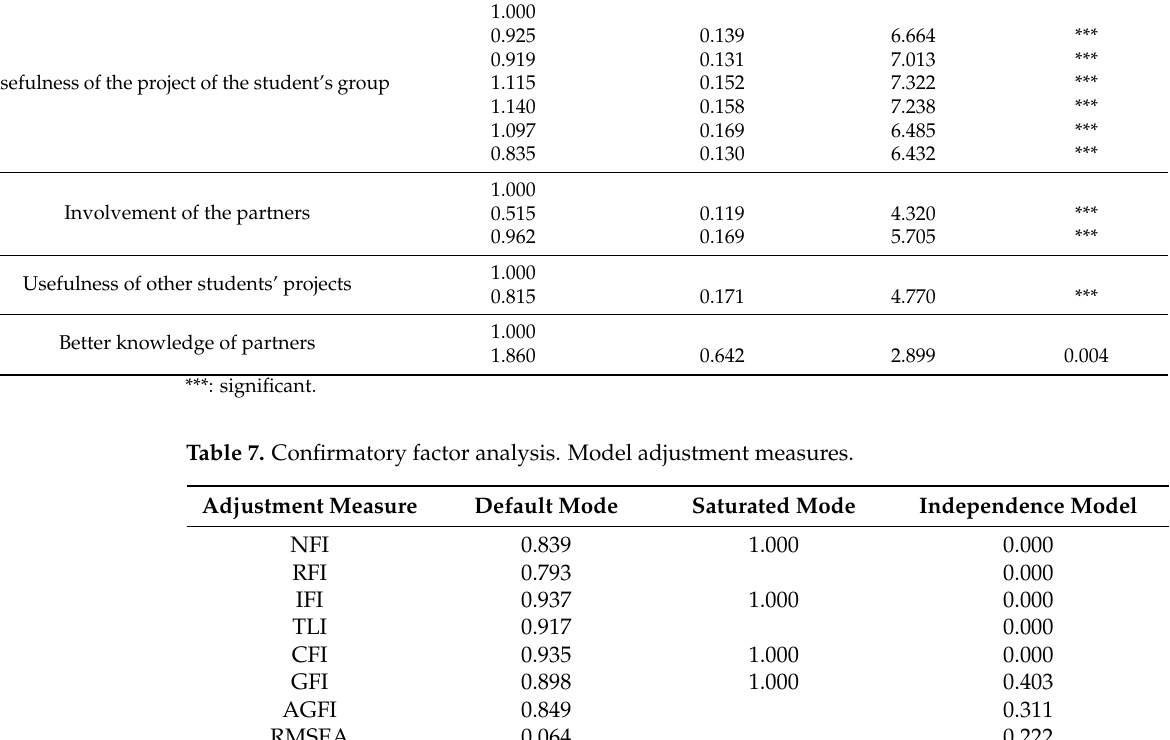
Figure 1. Measures of internal consistency of the construct by confirmatory factor analysis, applying maximum likelihood estimation method. Regression values, critical ratio, standard errors, and significance were estimated (Ta- ble 6). Critical ratio weights were high, and the disparities were significant in all the pa- rameters. Table 6. Regression weights, standard errors, critical ratios, and significances.